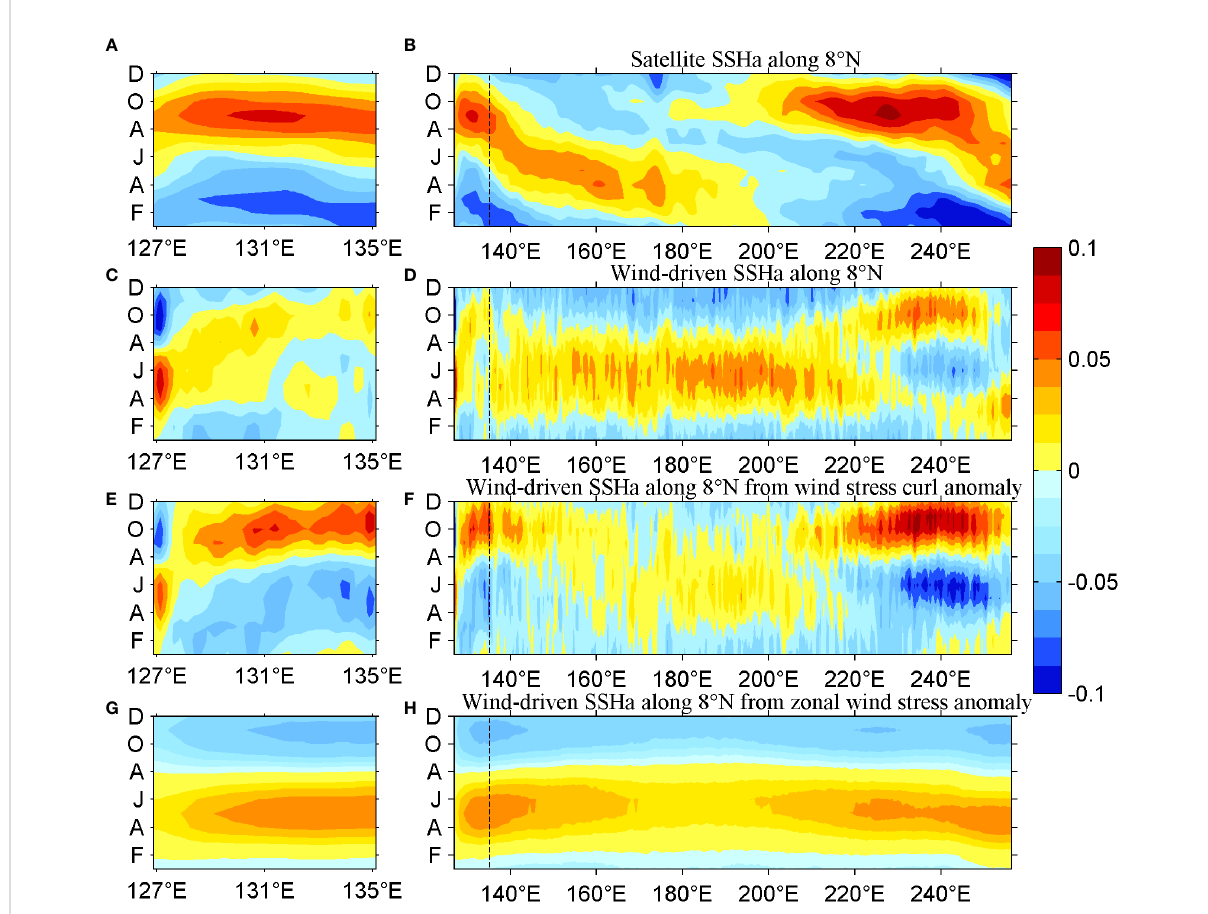
FIGURE 10 Longitude – time diagrams of seasonal SSHa along 8°N from satellite data (1993 – 2019) (A) along the western boundary and (B) in the North Paci fi c Ocean. Diagrams of wind-driven SSHa along 8°N based on QuikSCAT products (1999 – 2009) calculated from Eq. (4) (C) along the western boundary and (D) in the North Paci fi c Ocean. Diagrams of wind-driven SSHa along 8°N based on QuikSCAT products (1999 – 2009) forced by wind stress curl anomaly (E) along the western boundary and (F) in the North Paci fi c Ocean, and by zonal wind stress anomaly (G) along the western boundary and (H) in the North Paci fi c Ocean. (Units are